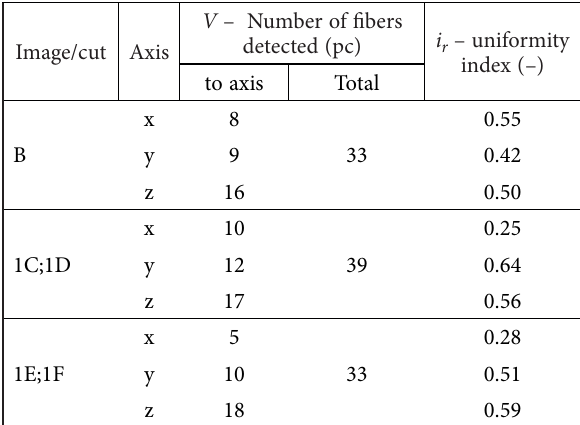
Table 7. The output table of the experimental core drill